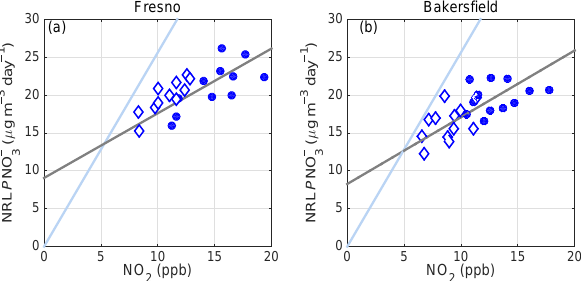
Figure 6. Calculated wintertime median P NO − (µgm − 3 day − 1 ) in 3 the NRL versus daytime (10:00–15:00LT) NO 2 (ppb) in Fresno (a) and in Bakersfield (b) . Calculations are shown separately for week- days (closed circles) and weekends (open diamonds). Fresno and Bakersfield results include years 2001–2012 and 2001–2013, re- spectively. There was no significant difference between medians and means. The light blue line has a slope of 2.56, expected for unit conversion of NO 2 to NO − (ppb to µgm − 3 ) . The actual NO − ver- 3 3 sus NO 2 slope (gray line) is calculated using a weighted linear least squares fit with errors assumed in both the x and y and weights that are the counting errors derived from the number of observations. The direction of time can be inferred from the NO 2 trends, as NO 2 concentrations have generally decreased each year over the